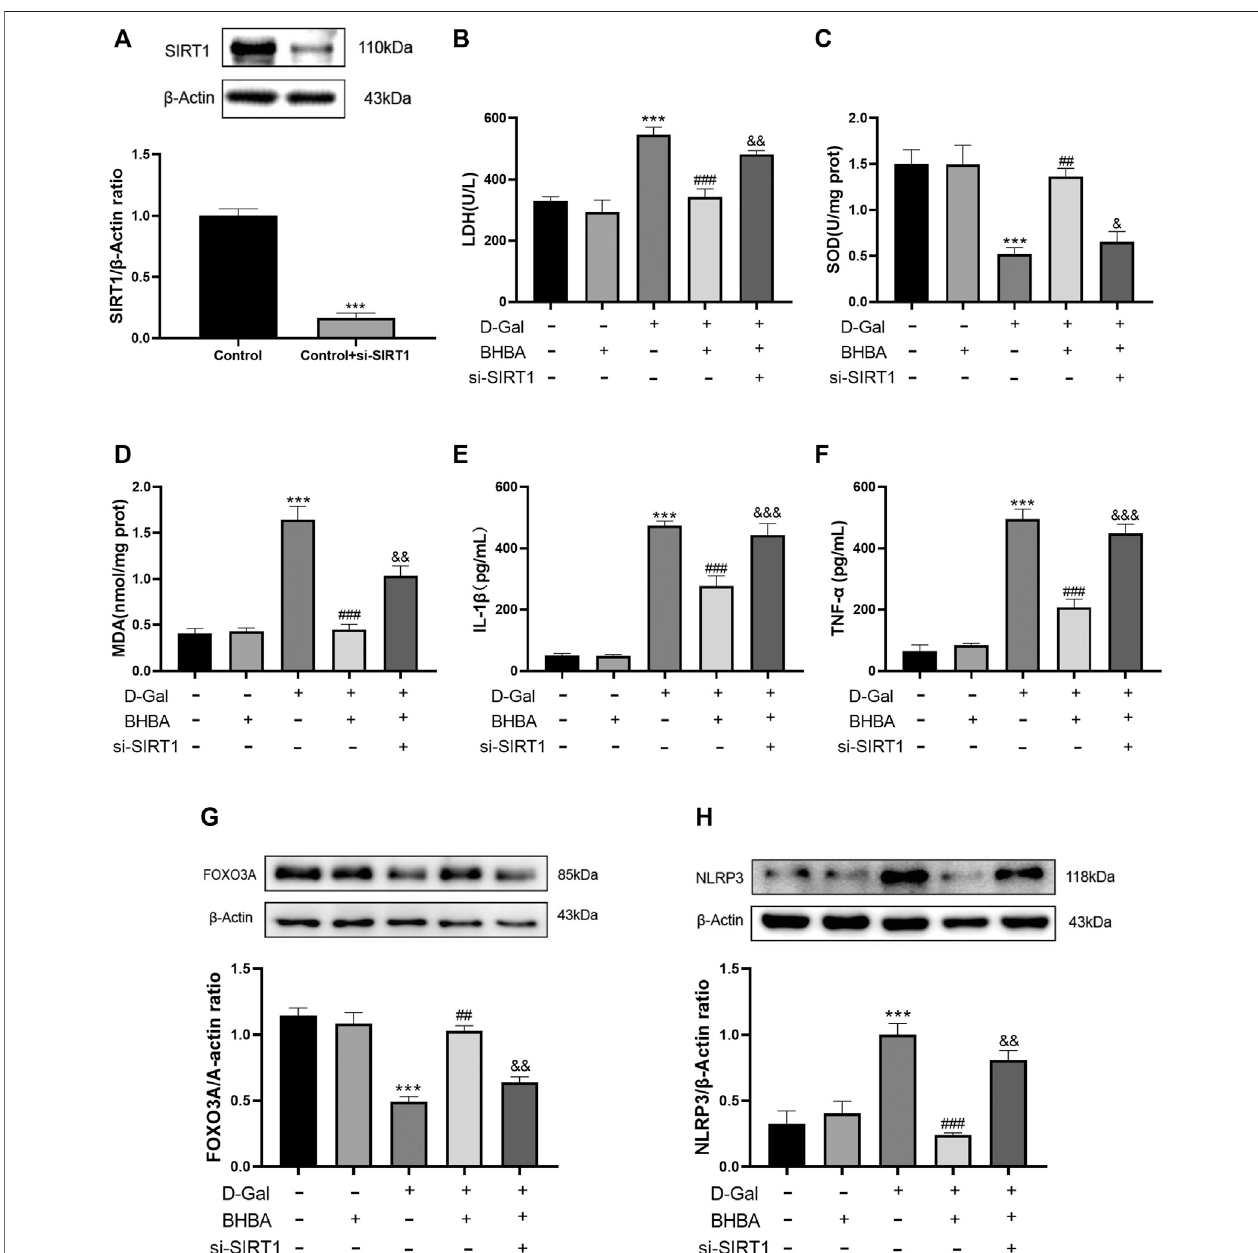
FIGURE 8| In fl uence ofsi-SIRT1 tothe effects of BHBA on D-gal-induced HT22 cells. (A) Protein expression ofSIRT1. (B) Activity ofLDH. (C) Activity ofSOD. (D) Content of MDA. (E) Content of IL-1 β . (F) Content of TNF- α . (G) Protein expression of FOXO3A. (H) Protein expression of NLRP3. D-gal: 200 mM; BHBA: 20 mM, n (cid:1) 3 – 5. Compared with the control group, *** p < 0.001; compared with the D-gal group, ## p < 0.01, ### p < 0.001; compared with the D-gal +BHBA group, && p < 0.01, &&& p < 0.001.